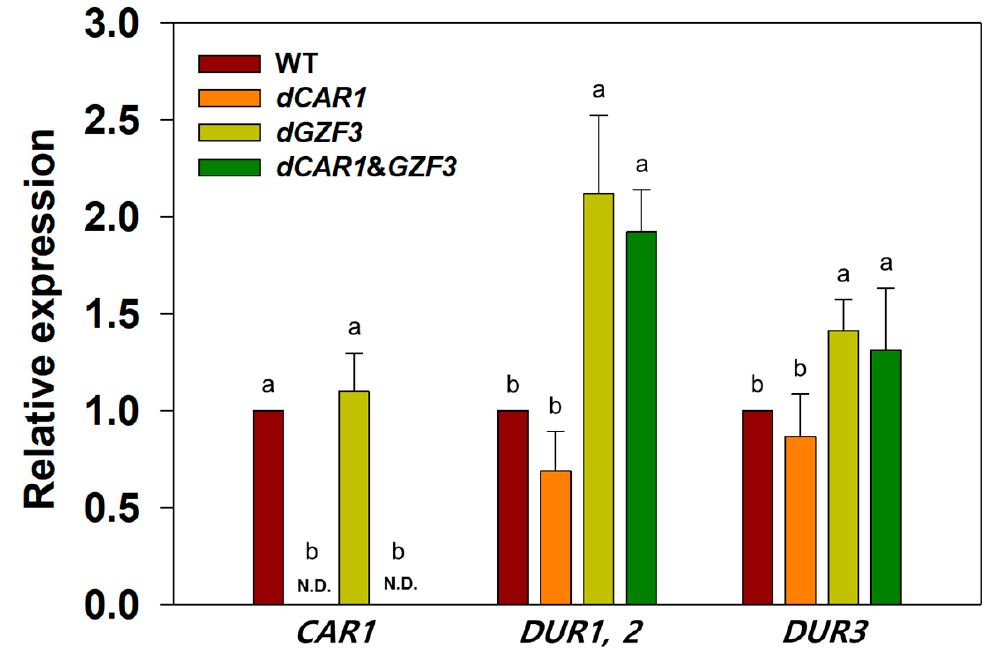
Figure 3. Determination of CAR1 , DUR1 , 2 and DUR3 gene expression levels in the wild-type S. cerevisiae GRL6, and the engineered S. cerevisiae dCAR1, dGZF3, and dCAR1 & GZF3 strains grown in the YPD8 medium with 50 mg/L urea and 50 mM arginine at 30 ◦ C for 6 h. The ACT1 gene was used as a reference for RT-qPCR analysis using the ∆∆ Ct method. Data were analyzed using One-way ANOVA to determine whether the expression levels of each gene in four strains are any statistically significant differences (a and b) between the means of the groups. The p -values of less than 0.05 were considered statistically significant. N.D.: Not Detected.